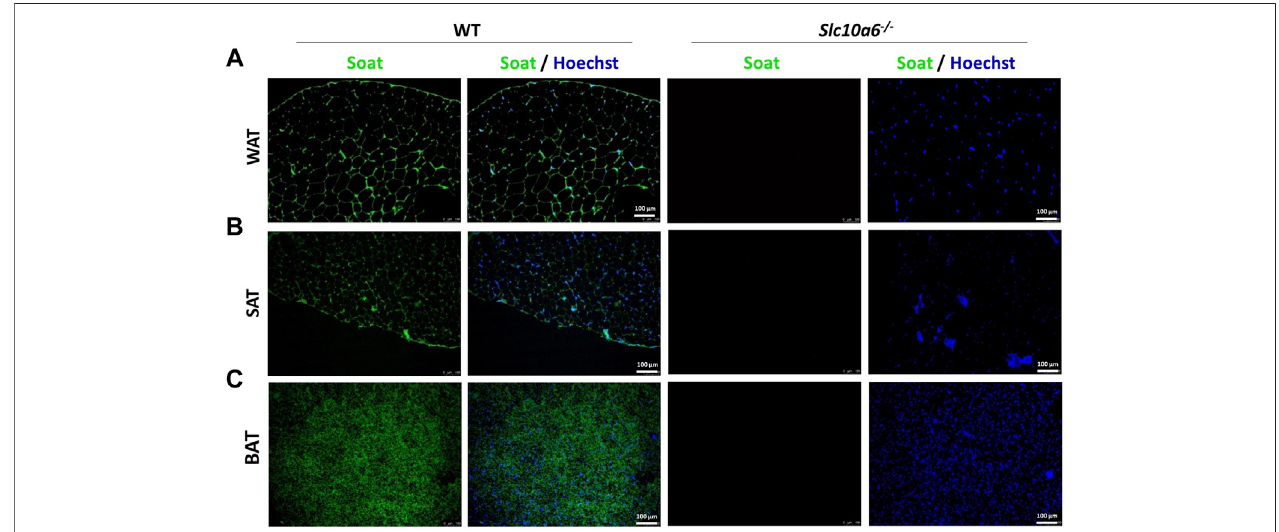
FIGURE1| Soatexpressioninmouseadiposetissues.ImmunostainingoftheSoatproteininWAT (A) ,SAT (B) ,andBAT (C) ofwild-typeand Slc10a6 − / − knockout mice with the anti-Soat antibody (green). Scale bar: 100 µm. Blue: nuclear counterstaining with Hoechst 33342. WT, wild type; WAT, white adipose tissue; SAT, subcutaneous adipose tissue; BAT, brown adipose